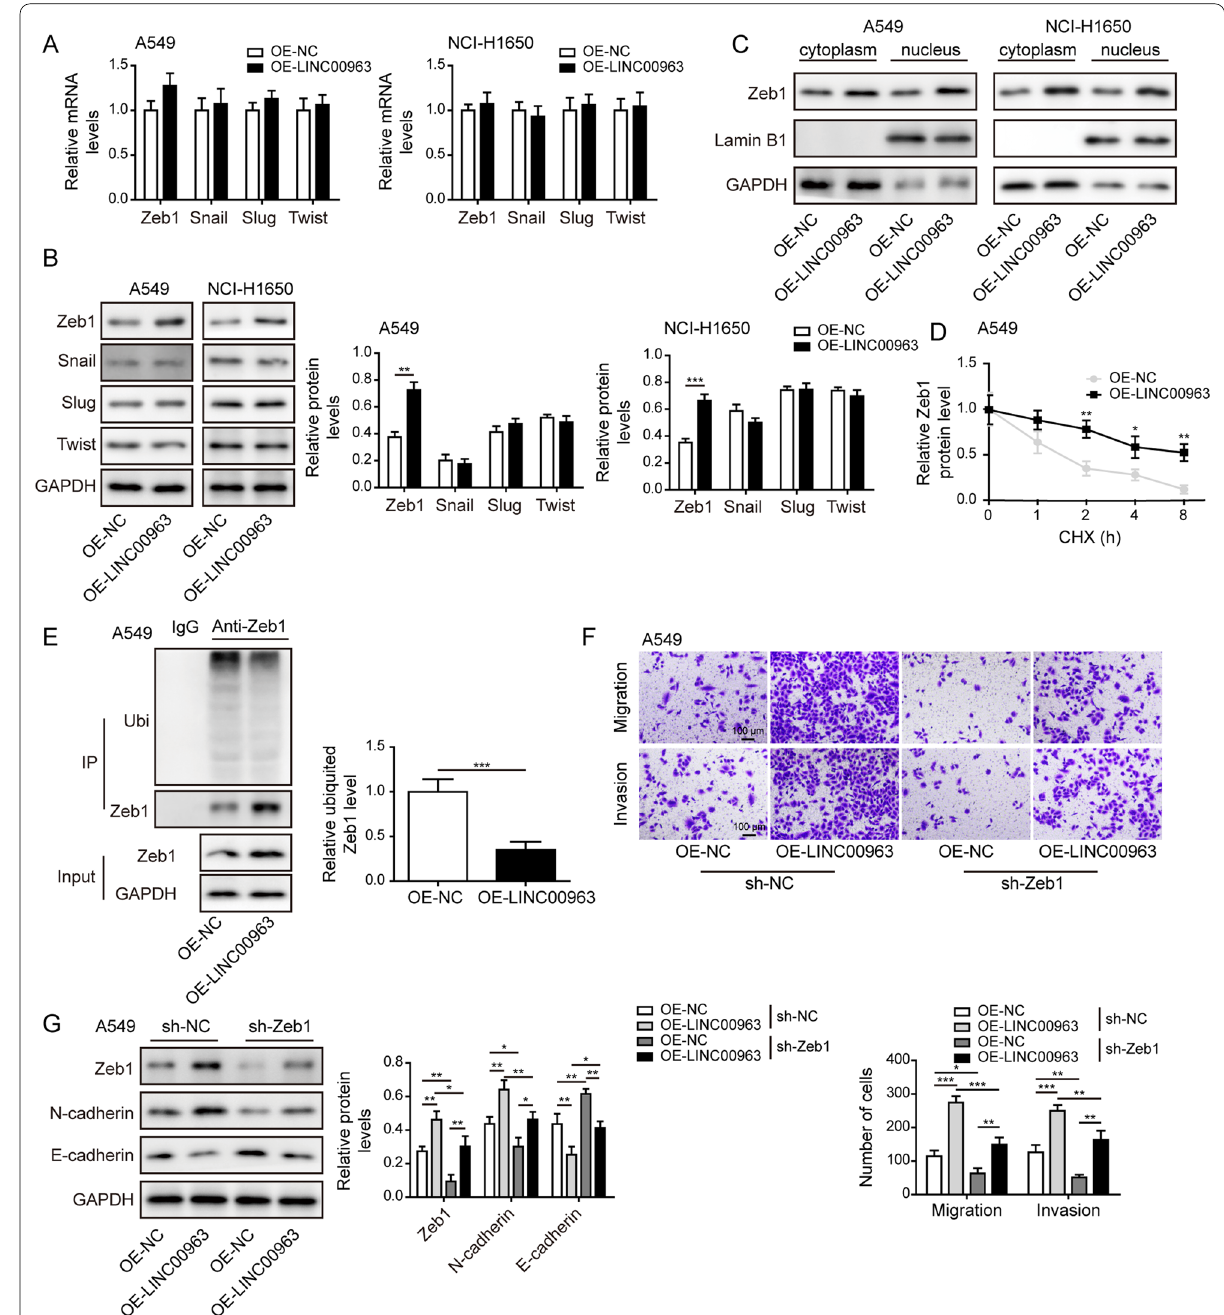
Fig. 5 LINC00963 stabilized Zeb1 by modulating its ubiquitination. Expression levels of Zeb1, Snail, Slug, and Twist in LINC00963 overexpressed cells were examined by RT-qPCR ( A ) and western blot ( B ). C Cytoplasmic and nuclear fractions were prepared from A549 and NCI-H1650 cells. Zeb1 expression was examined by western blot. D Stability of Zeb1 protein was examined by CHX chase assay in LINC00963 overexpressed A549 cells. E Ubiquitinated Zeb1 was measured by Co-IP assay in LINC00963 overexpressed A549 cells. F Migration and invasion were assessed by Transwell assays in indicated A549 cells. Scale bar: 100 μm. G Western blot was performed to test Zeb1, E-cadherin, and N-cadherin protein levels. * P < 0.05, ** P < 0.01 and *** P <